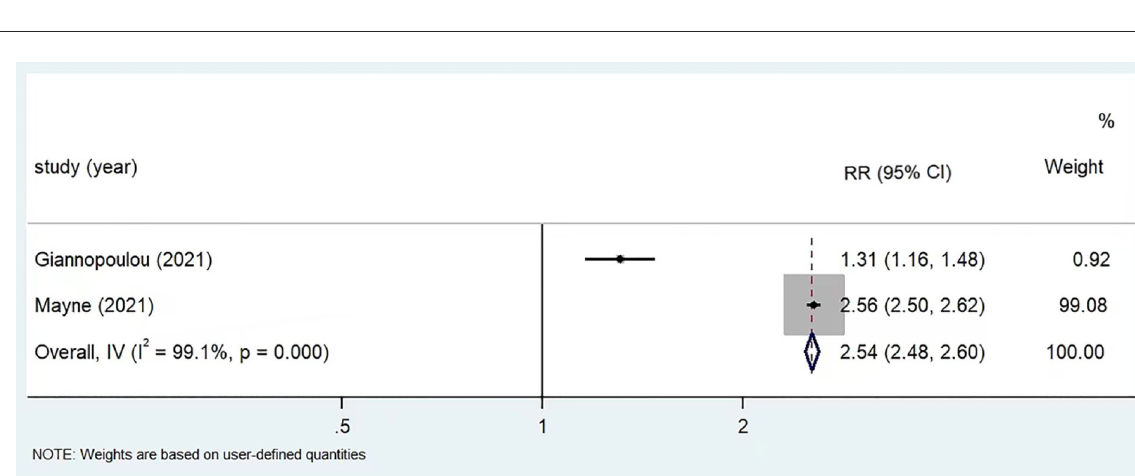
for Andreas and Brunborg (30), the increase was insignificant (SMD: 0.05, 95% CI: − 0.03, 0.13). The two studies used PHQ- 8 all found higher depression score after COVID-19 pandemic, with SMDs of 0.28 (95% CI: 0.02, 0.54) for Jolliff et al. (28) and 0.20 (95% CI: 0.01, 0.38) for Gladstone et al. (31). The two studies used MFQ also yielded positive findings, with SMDs of 0.32 (95% CI: 0.18, 0.47) for Black et al. (26) and 0.08 (95% CI: 0.02, 0.14) for Westrupp et al. (33). Meta-analysis results based on random-effect model revealed statistically increased depression score in post COVID-19 period for all three subgroups: the combined SMDs were 0.17 (95% CI: 0.10, 0.24), 0.23 (95% CI: 0.08, 0.38), and 0.11 (95% CI: 0.06, 0.17) for PHQ-9, PHQ-8, and MFQ,